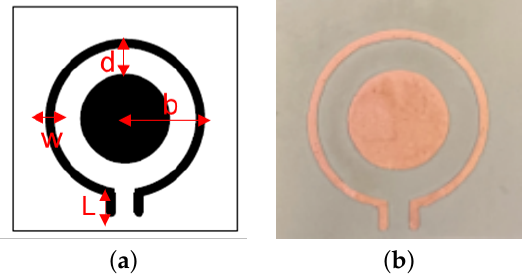
Figure 1. ( a ) The configuration of the tuned sensor: radius b = 5.7 mm, loop width w = 0.7 mm, stub length L = 1.5 mm, tuning gap d = 1.95 mm. ( b ) Photograph of the tuned sensor on a flexible polyimide substrate in its flat